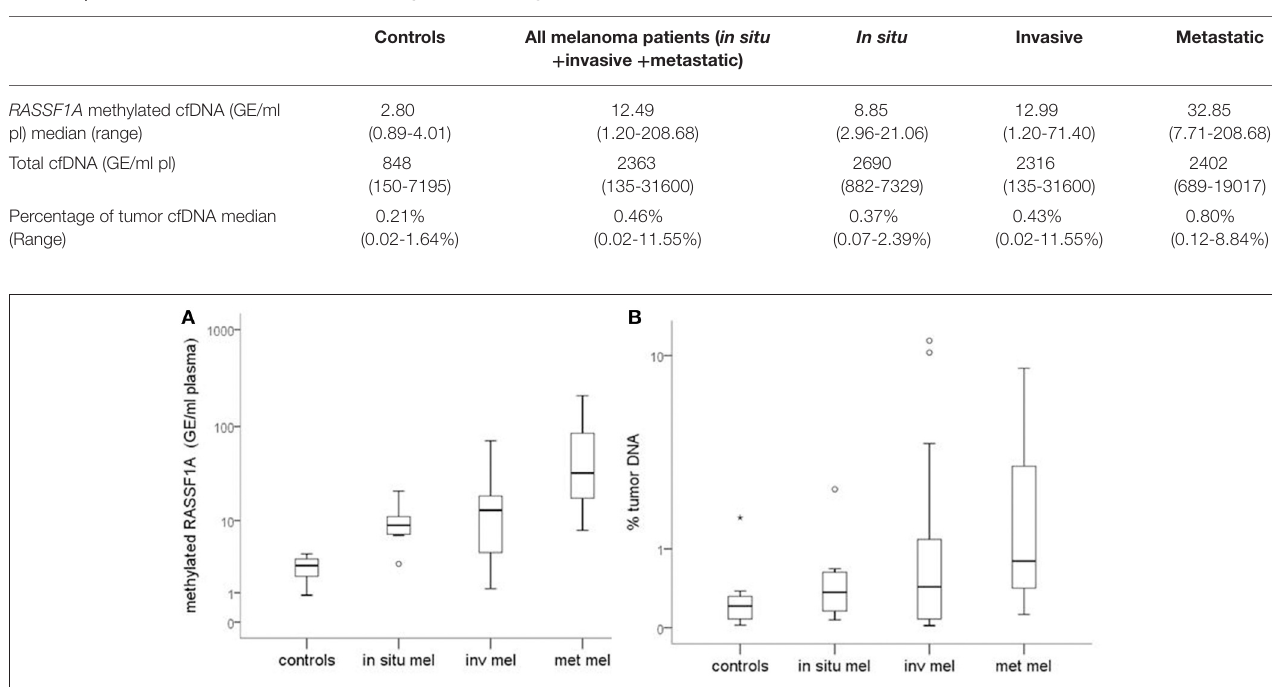
FIGURE 1 | (A) Quantity of RASSF1A methylated cfDNA in different classes of melanoma patients and control subjects. (B) Percentage of tumor DNA circulating in the plasma of different classes of melanoma patients and control subjects. Box plots represent the median values and interquartile range of RASSF1A methylated cfDNA. mel, melanoma; inv, invasive; met,